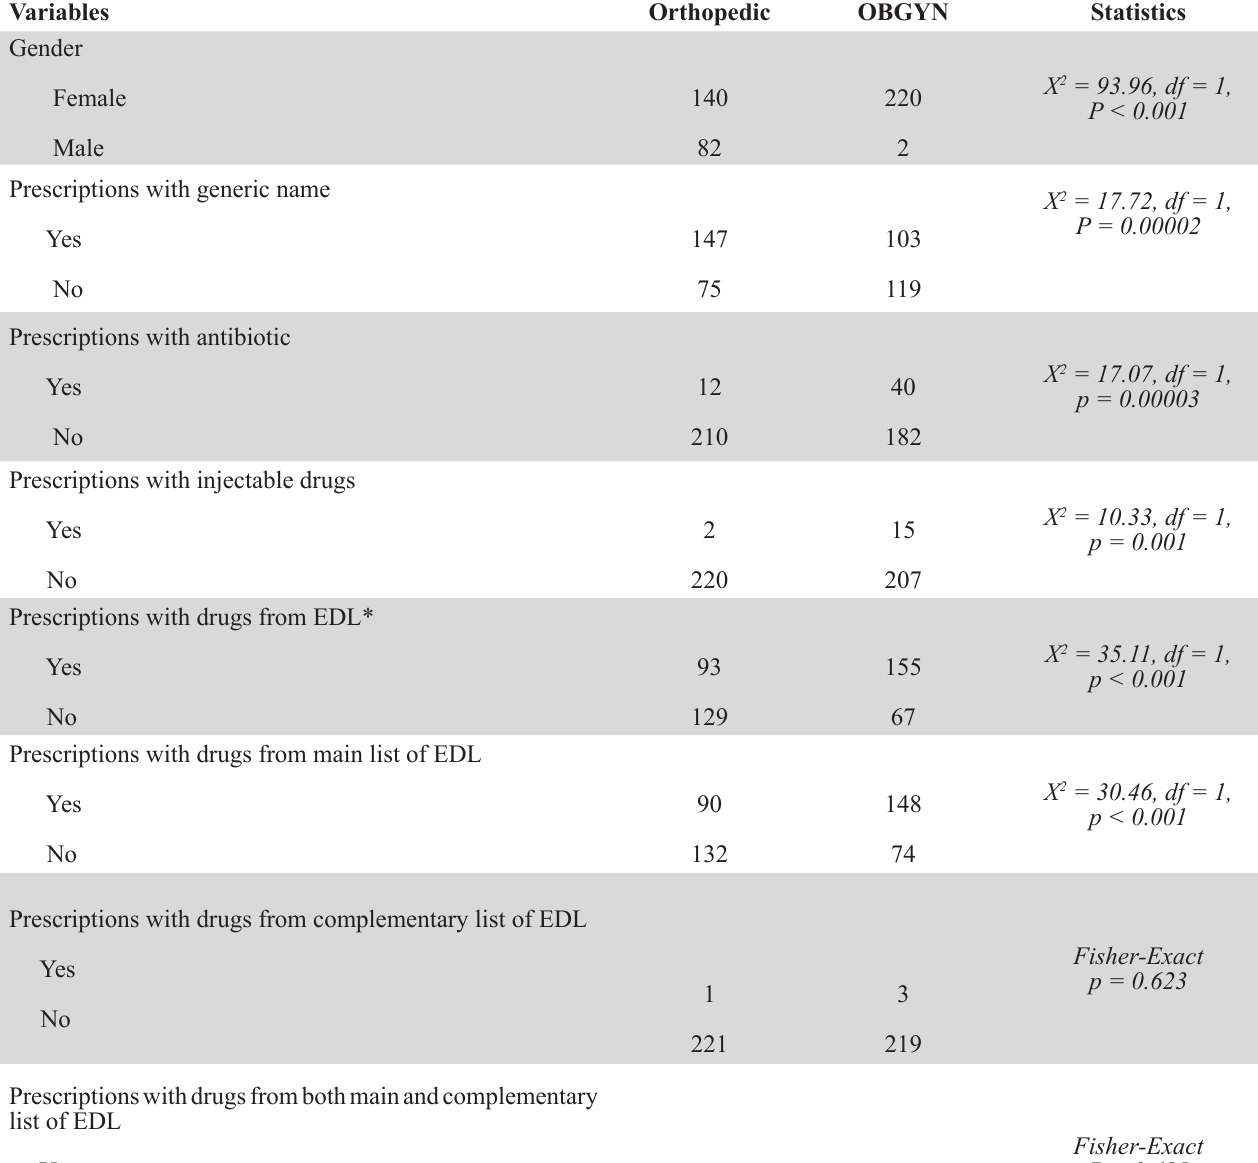
Table 3: Comparison of variables between orthopedic and OBGY departments (N = 444)